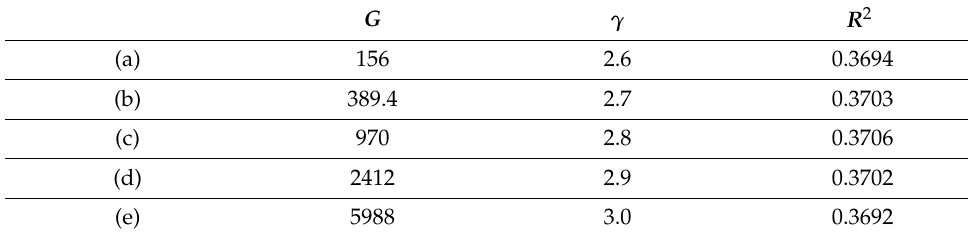
Table 3. Parameter results of developed